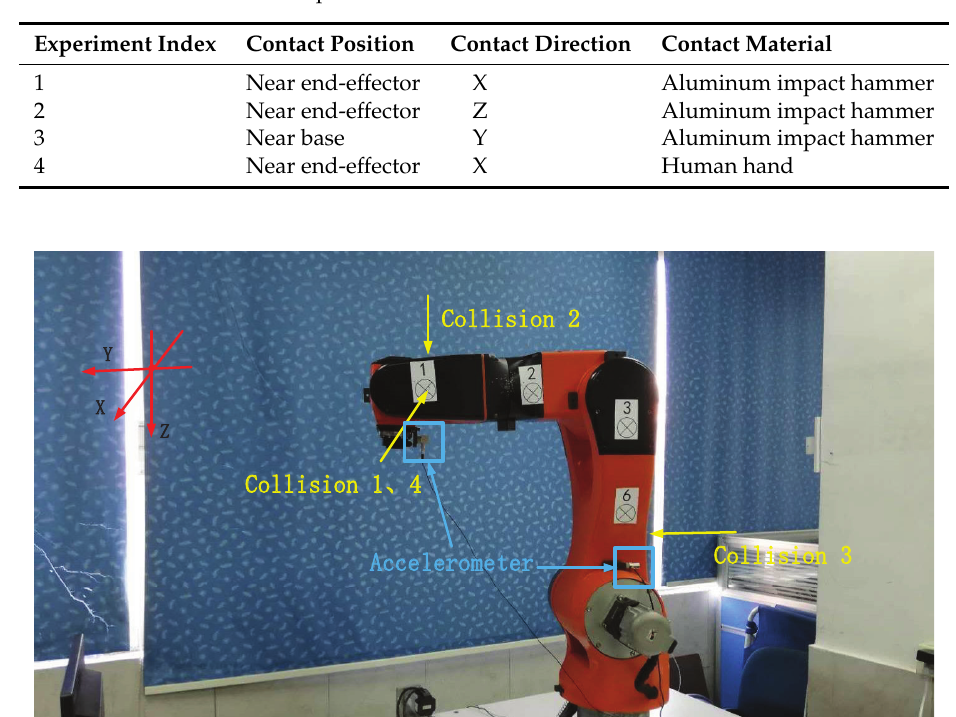
Table 1. Experiment conditions for vibration modal test.